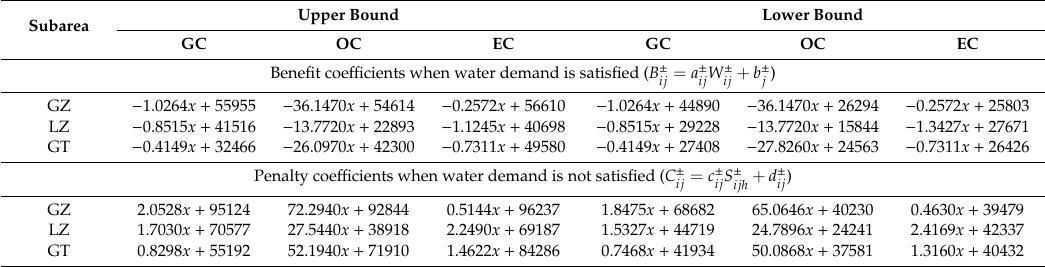
Table4. Thecoe ffi cientsofbenefitandpenaltycurvebasedonintervalregressionanalysis(Yuan / 10 4 m 3 ).